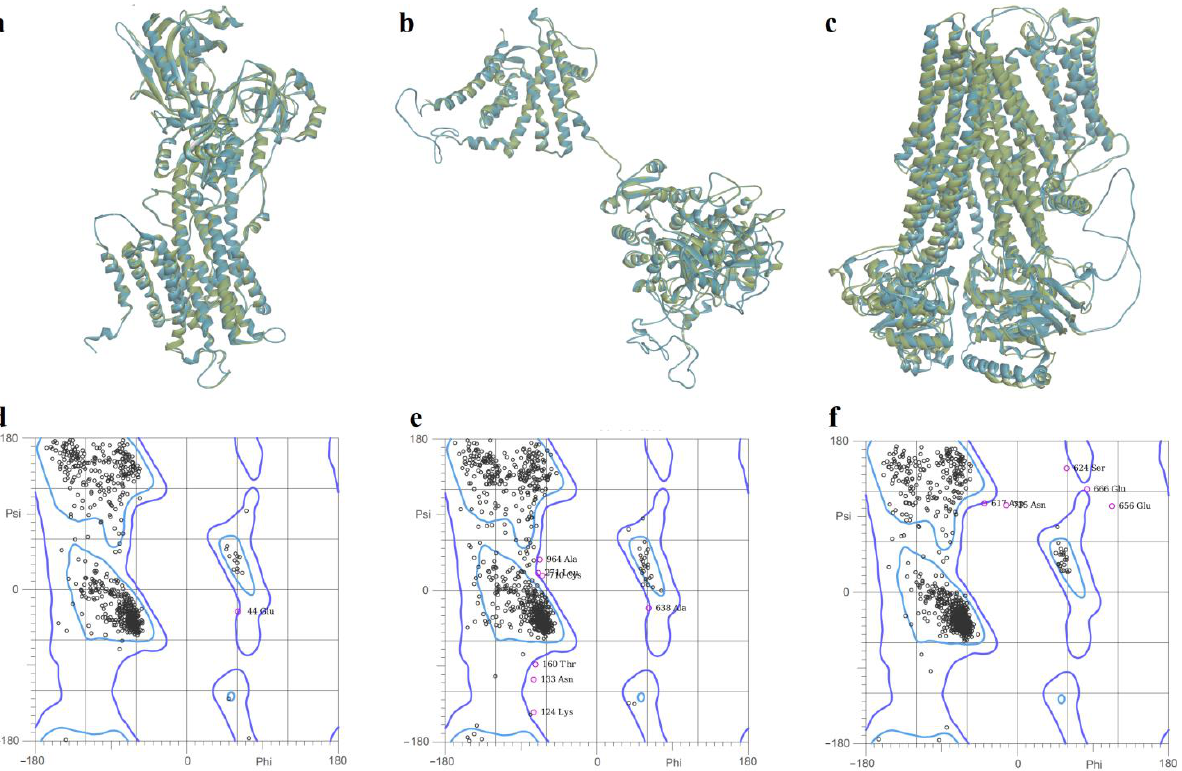
Figure 5. ( a ) — Superposition of SERCA2b model generated with YASARA (blue) on experimental (green) structure (PDB ID: 6LN9); ( b ) — superposition of Slo1 model (monomer) generated with SWISS-MODEL (blue) on experimental (green) structure (PDB ID: 6V35); ( c ) — superposition of SUR2 model generated with AlphaFold (blue) on experimental (green) structure (PDB ID: 7MIT); ( d ) — Ramachandran plot for SERCA2b model; ( e ) — Ramachandran plot for Slo1 model; ( f ) — Ramachandran plot for SUR2 model.